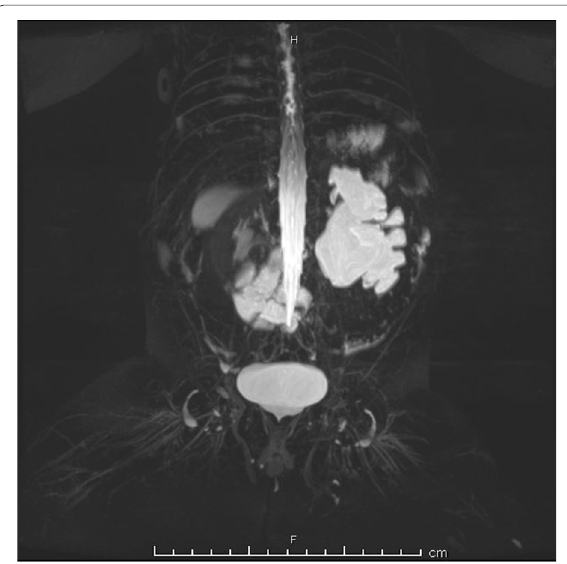
Fig. 3 Coronal view of magnetic resonance urogram showing left gross hydronephrosis with cutoff at pelviureteric